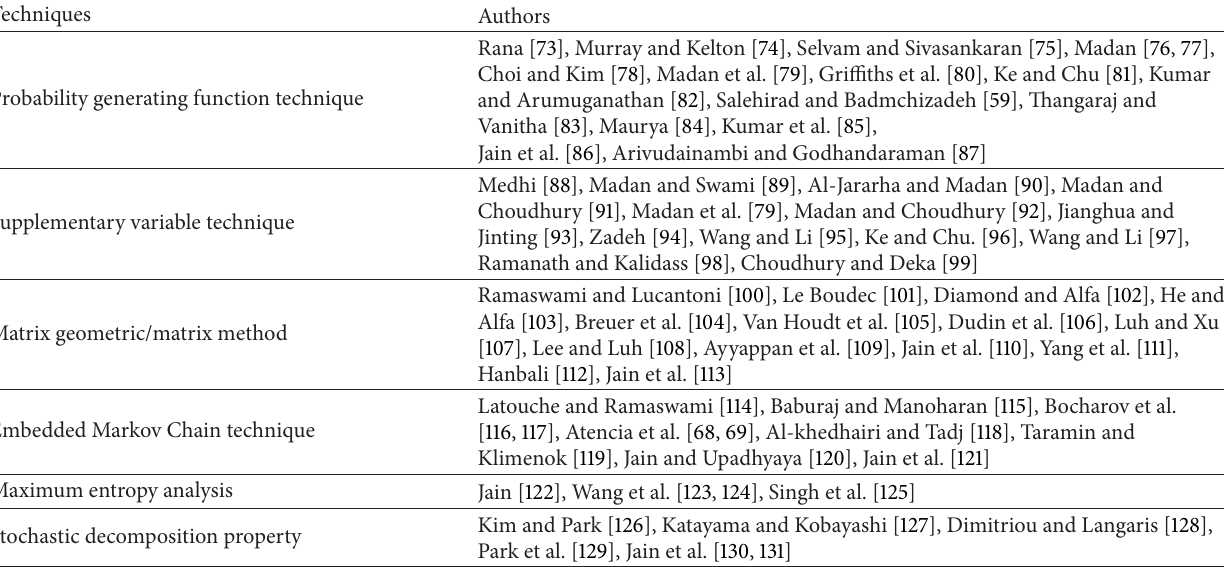
Table 1: Contributions on phase service queueing models using different